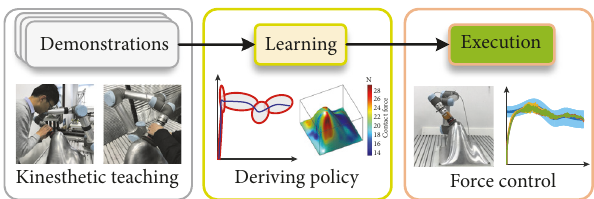
Figure 1: Frameworkof learning force-relevantskills. With multiple human demonstrations, a probabilistic task representation model is learned, from which a trajectory and force profile for the task are